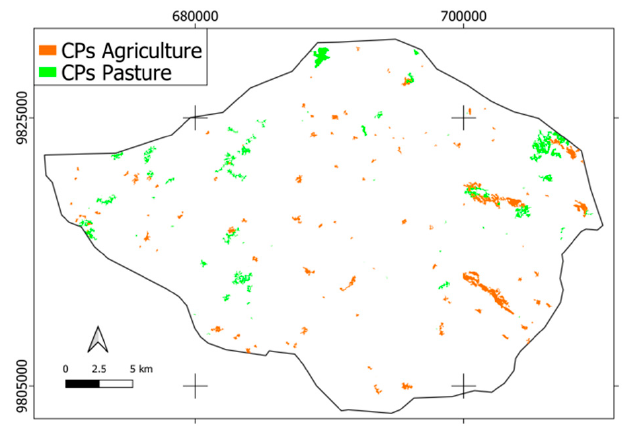
Figure 5. The CPs’ distribution in Katoyi collectivity (Reference Frame: WGS84/UTM35S).